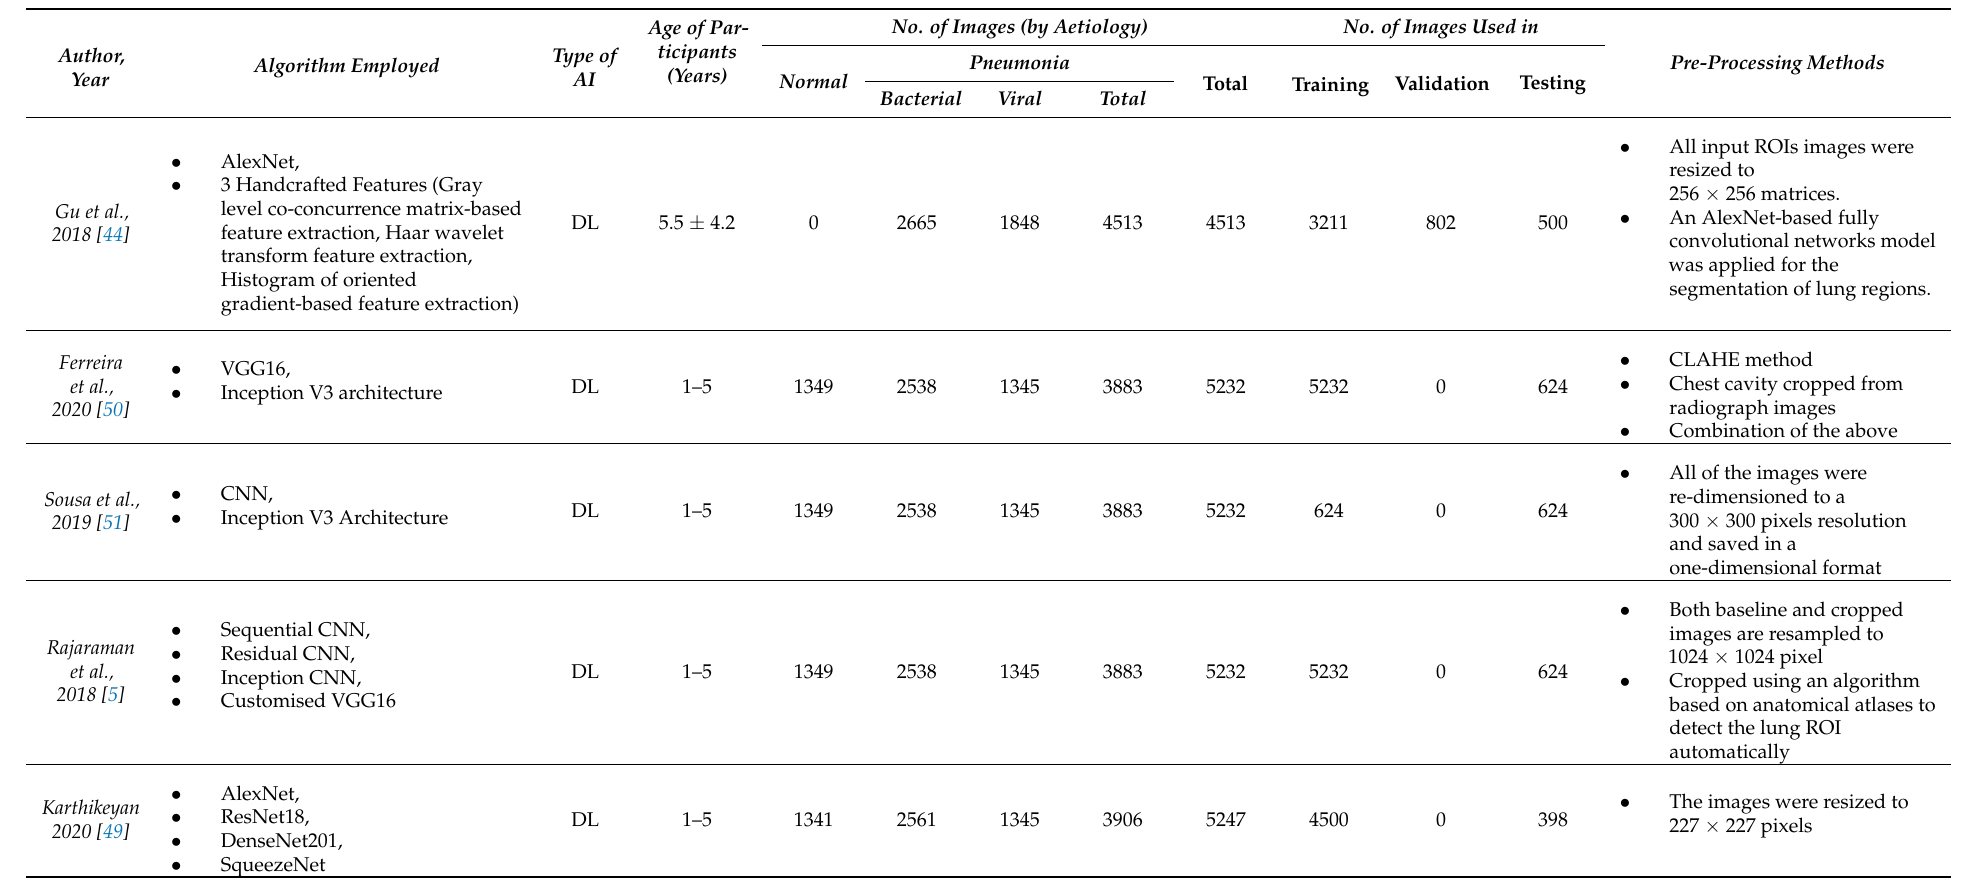
Table 1. Characteristics of the AI algorithm employed, pre-processing methods utilised, as well as detailed descriptions of each dataset used in each of the included studies. Abbreviations: N/A (not applicable), ROI (region of interest), CLAHE (contrast limited adaptive histogram equalisation), CNN (convolutional neural